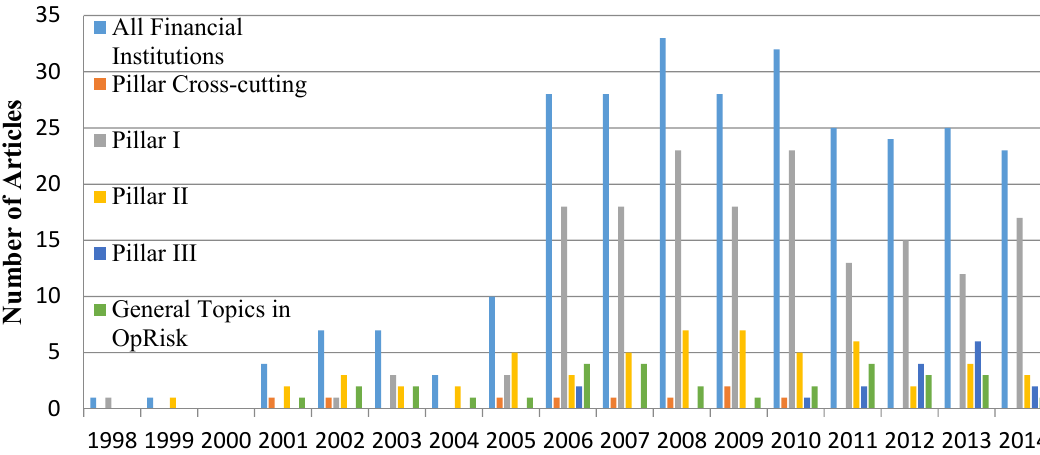
Figure 2. Development of the operational risk literature.